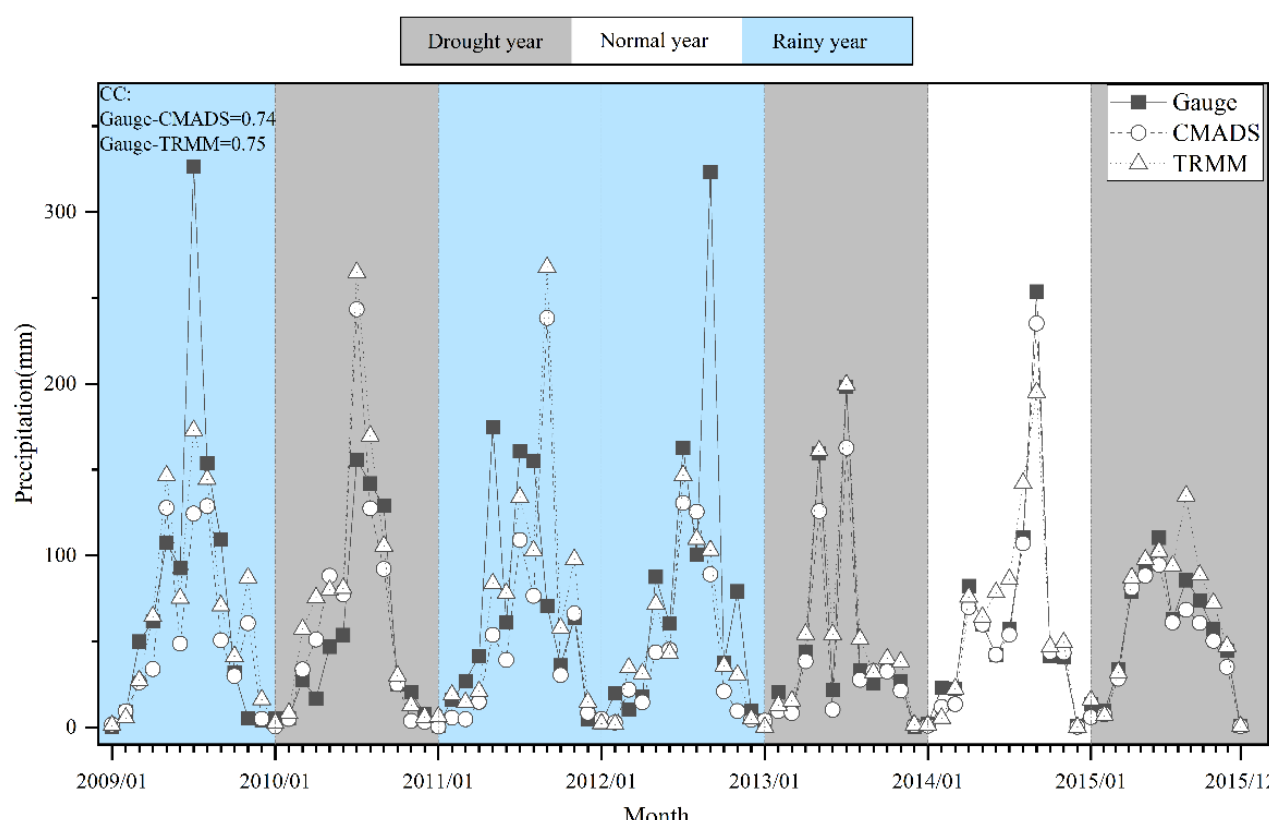
Figure 2. Three different precipitation records at monthly scale in the DRB (the CC value of Gauge-CMADS and Gauge–TRMM were 0.74 and 0.75, respectively; 2009, 2011, and 2012 were denoted as rainy years, 2014 was denoted as the normal year, and 2010, 2013, and 2015 were denoted as drought years. Additionally, the data in this figure were given as year and month.